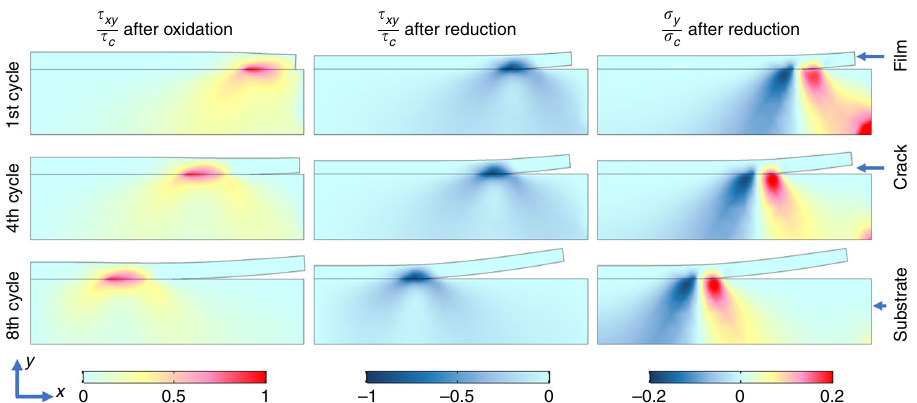
Fig. 4 Contour plots of the shear stress τ xy in PProDOT at the oxidized state, τ xy at the reduced state, and the normal stress σ y at the reduced state after the 1 st , 4 th , and 8 th cycles, respectively. Deformation is drawn in the